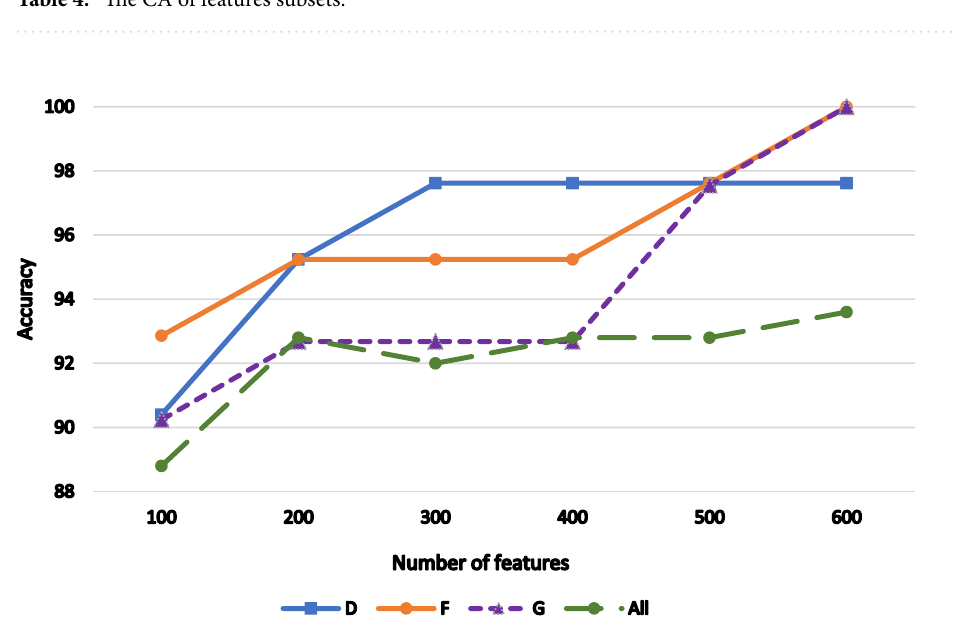
Table 4. The CA of features subsets.